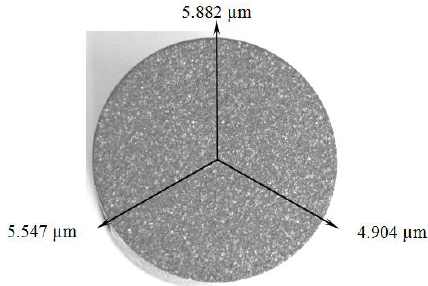
Figure 1. Macroscopic image of the Al 2 O 3 ·30(Ni 20 Al) plasma deposited layer on the surface of CuAl10Ni5Fe2.5Mn1 sample (15.8 mm diameter) with the measured Rz data. Average Rz: 0.063 μm for the polished base material; and 5.445 μm for the plasma deposited layer.